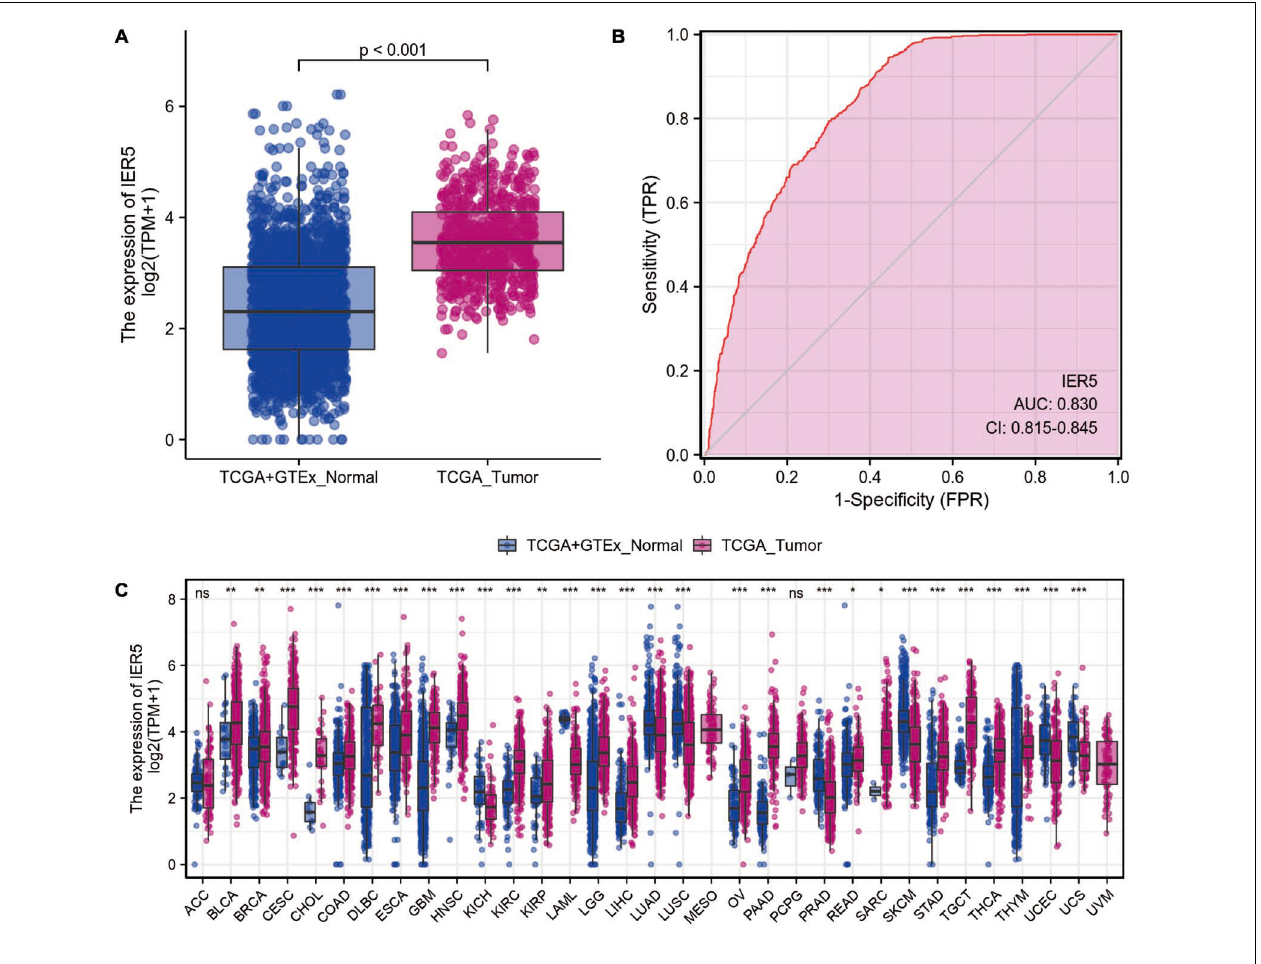
FIGURE 1 | The difference in IER5 expression levels between tumor and normal tissues. (A) Expression levels of IER5 in glioma and normal samples. (B) ROC analysis of IER5 expression showing promising discrimination power between glioma and non-tumor tissues. (C) Pancancer analysis of IER5 expression